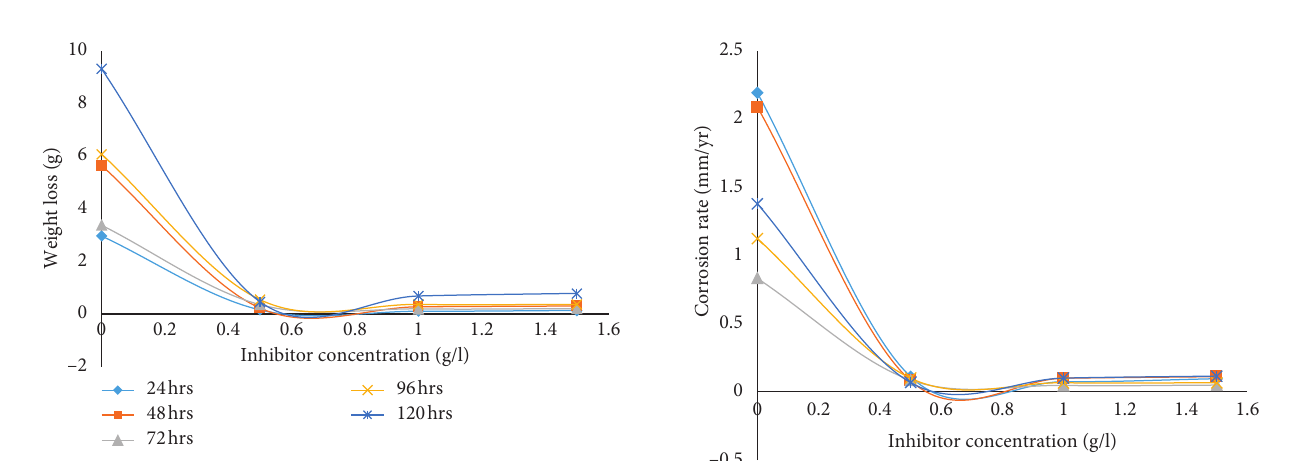
Figure 2: Weight loss (g) variation of mild steel in dilute H with inhibitor concentration (g/l).